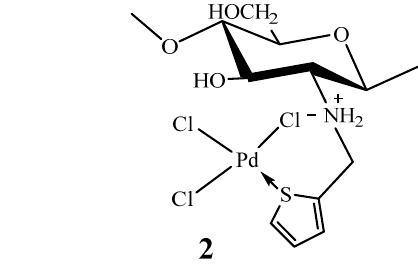
derivatives: 1—ion-exchange; 2 and 3—coordination; 4—reduction.